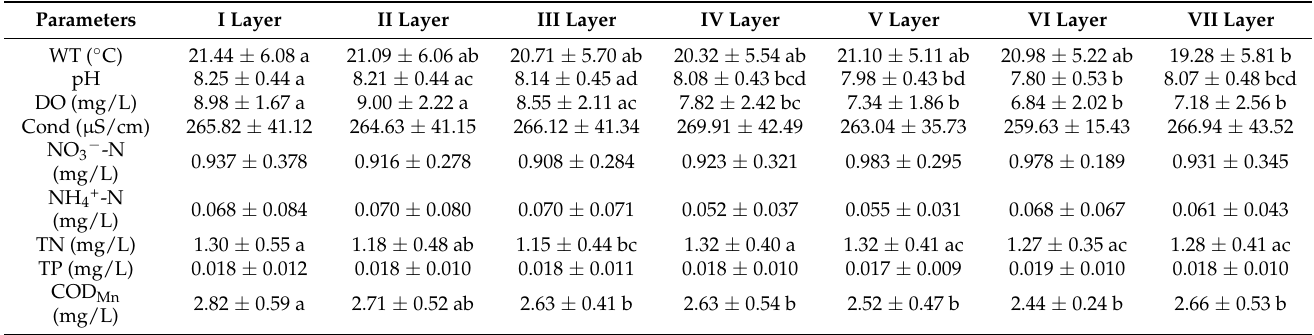
Table 1. Variation of vertical water quality factor parameters in the Danjiangkou Reservoir.